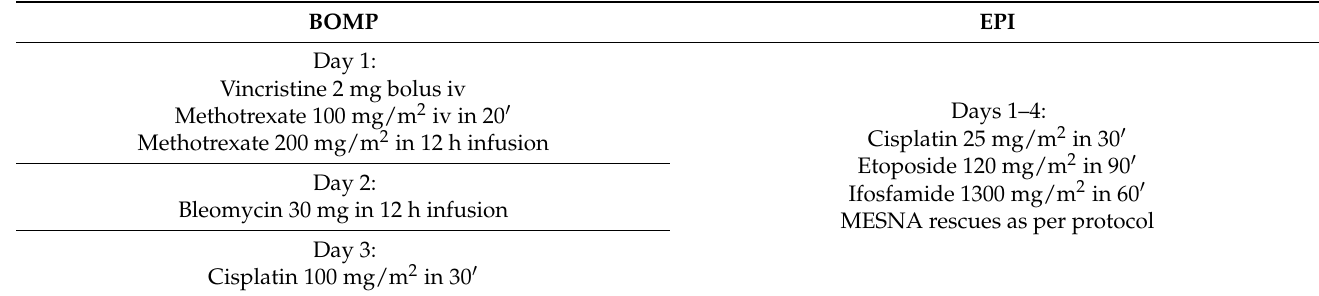
Table 6. Details of BOMP-EPI